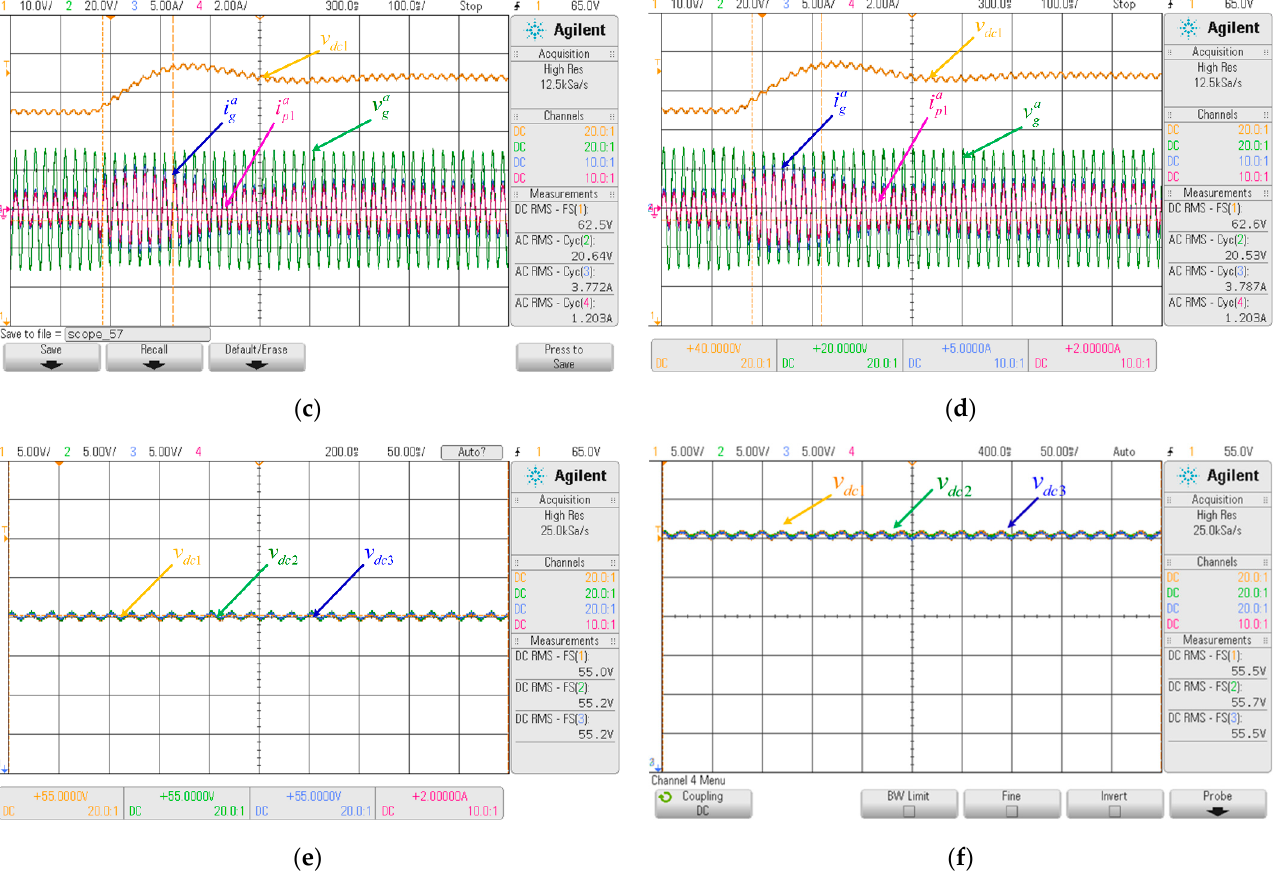
Figure 10. Experimental results V DC voltage loop. ( a ) Transient response to step change with k sw = 0.00. ( b ) Transient response to step change with k sw = 0.12. ( c ) Input current change by step change in V DC voltages with k sw = 0.00. ( d ) Input current change by step change in V DC voltages with k sw = 0.12. ( e ) Steady-state V DC voltages with k sw = 0.00. ( f ) Steady-state DC voltages with k sw = 0.12.